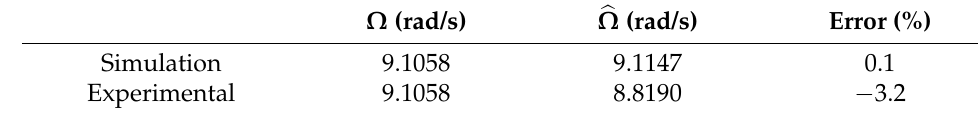
Table 3. Performance of the online frequency estimation for the second configuration.